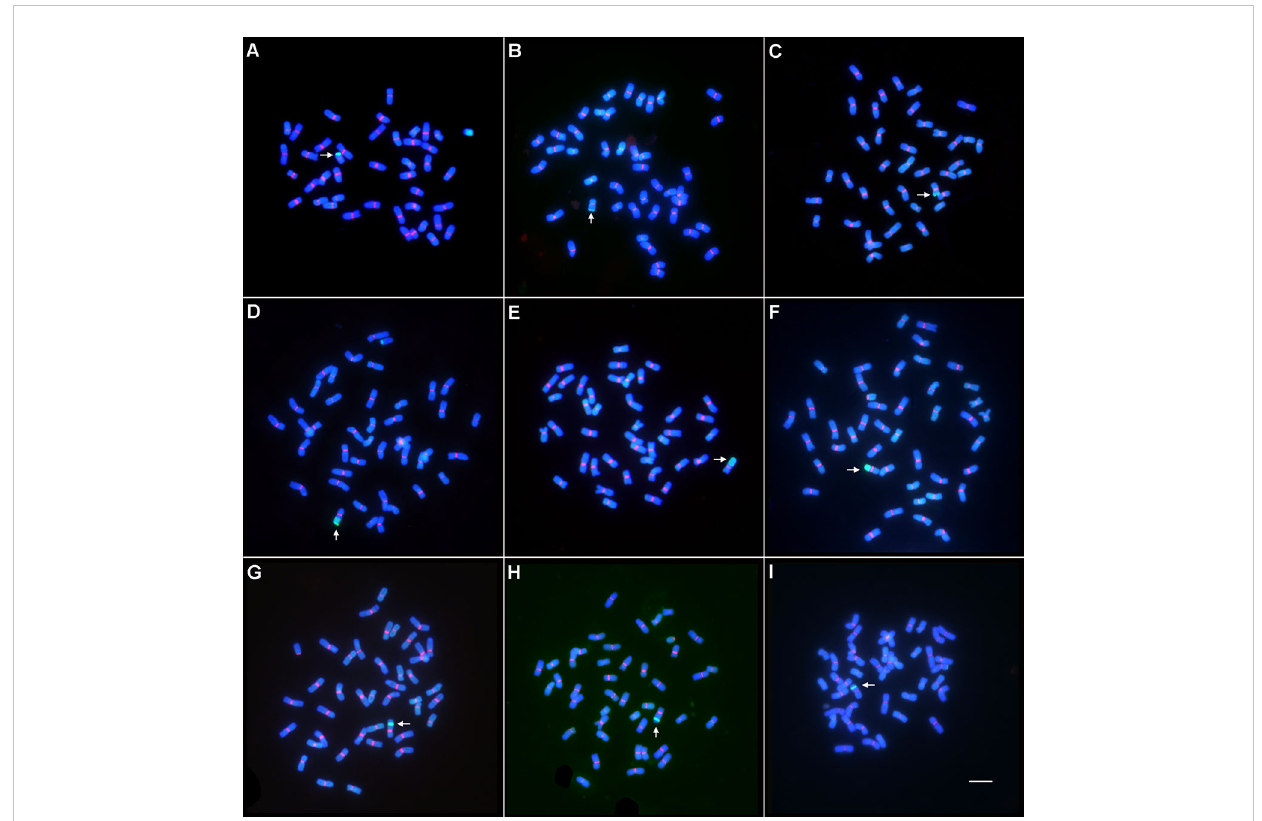
FIGURE 2 Wheat – Th. intermedium translocation line identi fi ed by GISH and FISH. The genomic DNA of Th. intermedium (green) was used as probe for GISH, and the wheat centromeric retrotransposon 6C6 (red) was used as probe for FISH. The genomic DNA of CS was used as a blocker. Chromosomes were stained with DAPI. Arrows indicated the translocated chromosomes. Scale bar = 10 m m. (A – C) The short alien segmental translocation lines identi fi ed by GISH and FISH. (A) Zhongke 55; (B) Zhongke 61; (C) Zhongke 316. (D – F) The long alien segmental translocation lines identi fi ed by GISH and FISH. (D) Zhongke 843; (E) Zhongke 70; (F) Zhongke 108. (G – I) The intercalary translocation lines identi fi ed by GISH and FISH. (G) Zhongke 21; (H) Zhongke 102; (I) Zhongke